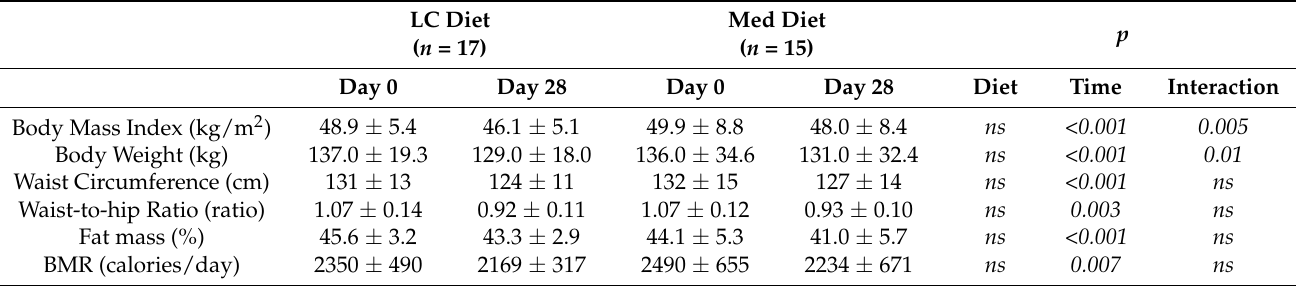
Table 2. Changes in body weight, adiposity and basal metabolic rate (BMR) induced by a low-carbohydrate diet (LC) or Mediterranean (Med) diet in morbidly obese individuals.